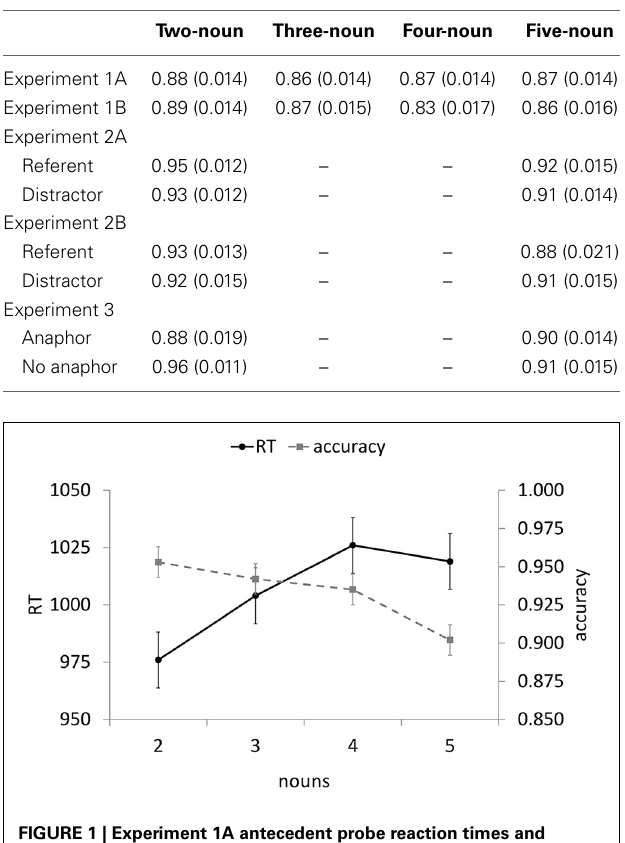
errors of the mean).